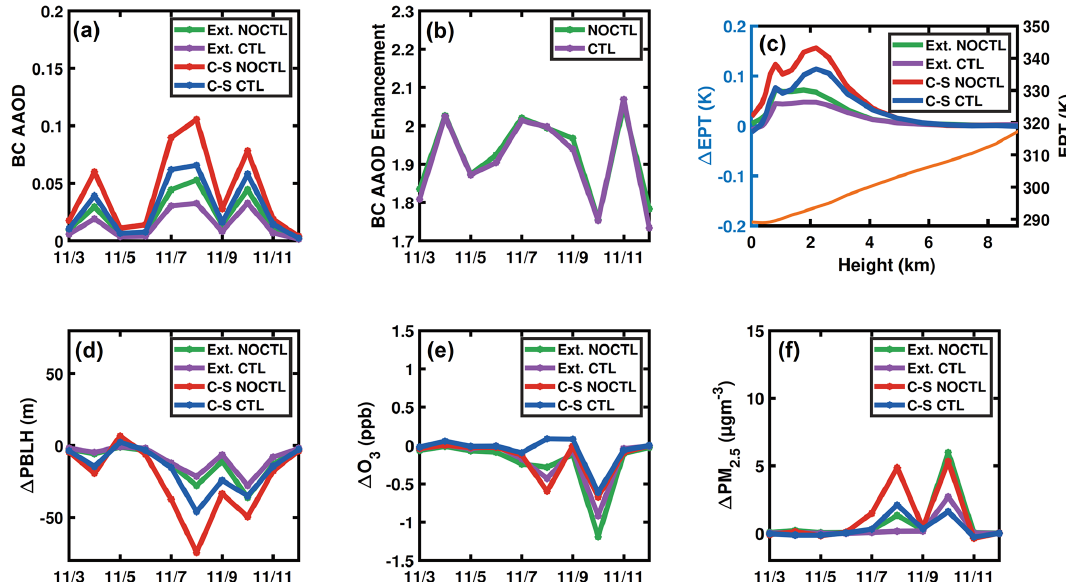
Figure 4. Daytime (10:00–17:00 local time) mean BC AAOD in Beijing inferred from different simulations (a) and the BC AAOD enhance- ment in the NOCTL and CTL scenarios (b) ; BC absorption induced changes in EPT (orange line indicates the vertical profile of EPT) (c) , PBLH (d) , O 3 (e) , and PM 2 . 5 (f) . Table 2. The division of the impact of BC absorption into the impact of BC mass itself and the BC mixing state. Influenced variables BC mass itself BC lensing effect Reduced coating Reduced E ab AAOD